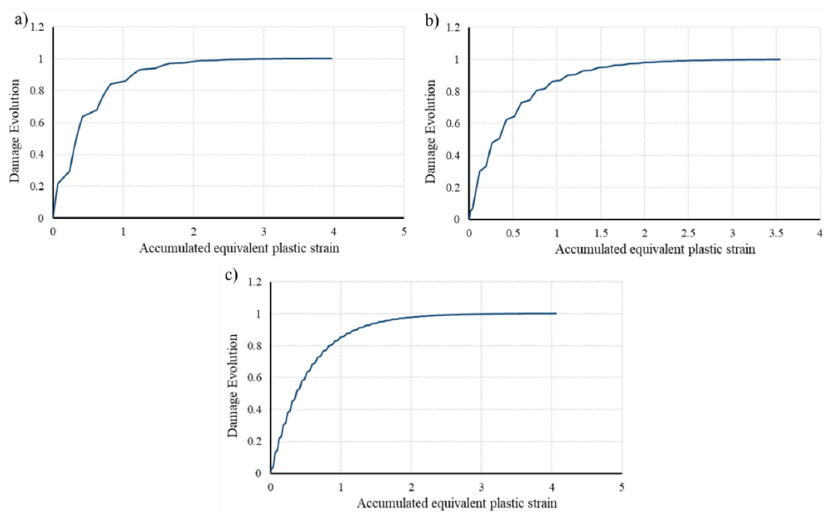
Figure 12. Damage accumulation for “PE” specimens under ELCF. ( a ) Damage accumulation for ten (N f = 10), ( b ) 21 (N f = 21), and ( c ) 43 high-strain reversed cycles (N f =